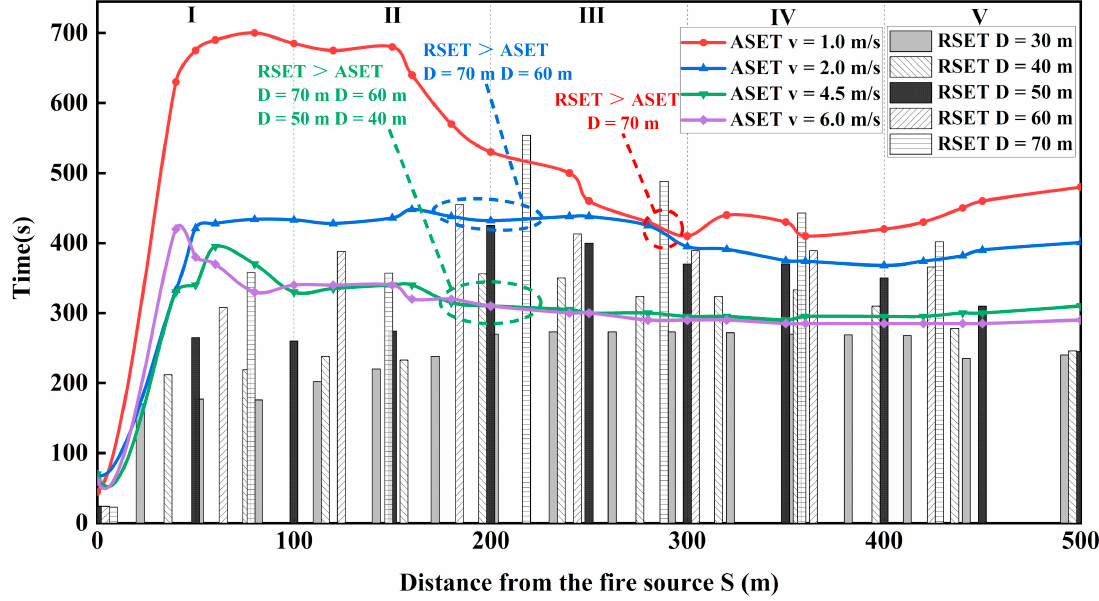
Figure 11. Comparison of RSET of different D with ASET of different velocities in the downstream area of fire source within 500 m. Table 10. Number and location of trapped passengers under different evacuation